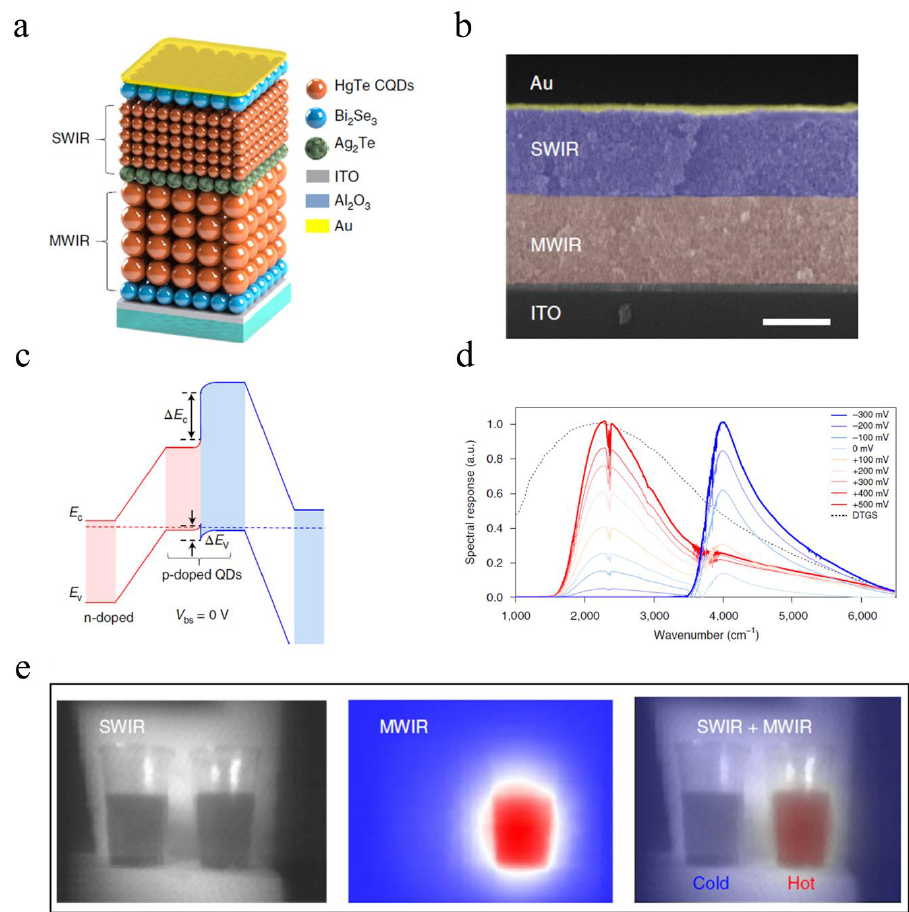
Figure 4. ( a ) Architecture of the two-terminal dual-band detector. ( b ) Cross-sectional Scanning electron microscopy image of the detector. Scale bar: 300 nm. ( c ) Energy diagram of the two-terminal dual-band detector at zero bias. ( d ) The spectral response of the detector varies with bias voltage from −300 to +500 mV. ( e ) Cold and hot water’s SWIR, MWIR and two-color composite images. Adapted with permission from [58]; Copyright 2019 Nature Publishing Group.